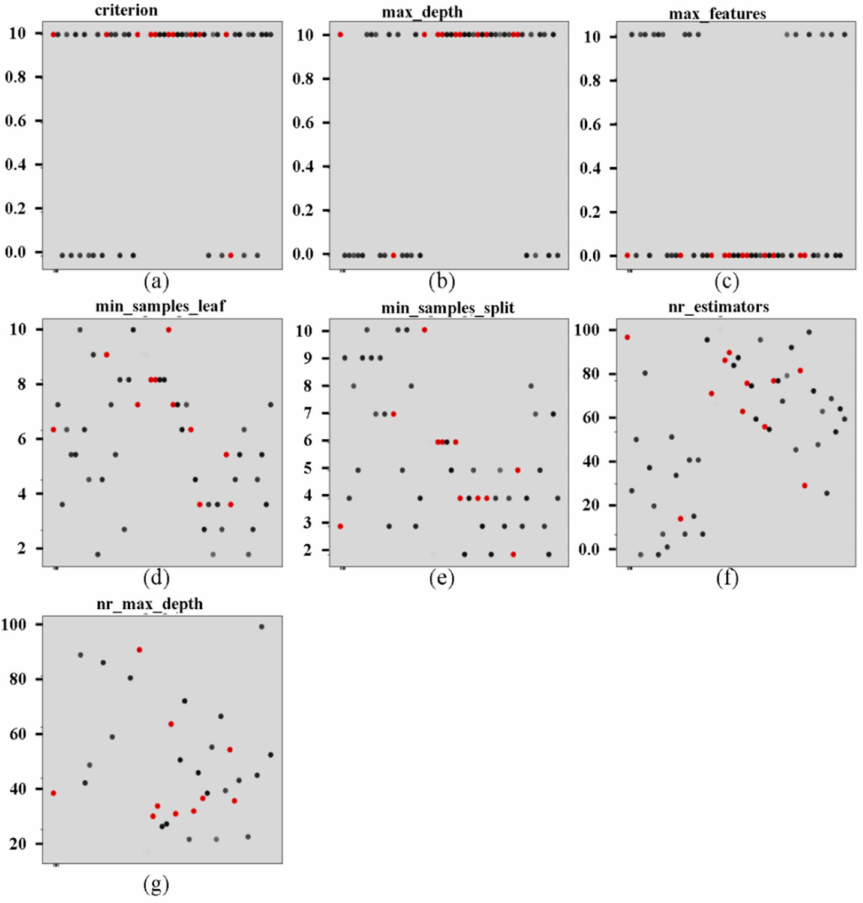
Figure 3. Scatter plot of best optimal model parameter with ( a ) ‘criterion’: 1, ( b ) ‘max_depth’: